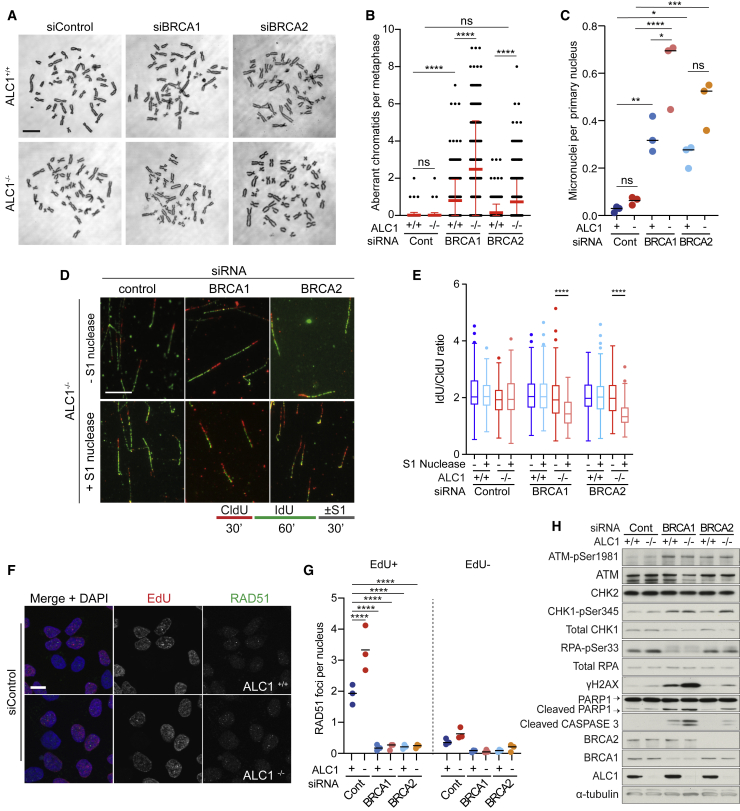
Loss of HR leads to single-stranded gaps at replication forks and gross genomic instability in ALC1−/− cells(A–D) Knockdown of BRCA1/2 in ALC1−/− cells results in genome instability. (A) Representative micrographs of metaphase spreads in ALC1+/+ and ALC1−/− eHAP transfected with the indicated siRNA. (B) Quantification of the number of aberrant chromatids per metaphase in ALC1+/+ and ALC1−/− eHAP transfected with indicated siRNA. Data are mean ± SEM (n = 3 independent biological experiments). (C) Quantification of number of micronuclei per primary nucleus from ALC1+/+ and ALC1−/− eHAP cells transfected with non-targeting, BRCA1-targeting, and BRCA2-targeting siRNAs. Data are means from individual experiments; bar represents median (n = 3 independent biological experiments). (D) Lower: scheme of the nucleotide labeling and S1 nuclease treatment strategy used for gap detection at the replication fork. Upper: Representative DNA fiber immunofluorescence images from ALC1−/− eHAP cells transfected with the indicated siRNAs and treated or not with S1 nuclease.Scale bars represent 100 μm.(E) Boxplot showing mean IdU/CldU ratio in ALC1+/+ and ALC1−/− eHAP transfected with the indicated siRNAs and treated or not with S1 nuclease. Data from 500–600 fibers/condition are represented as mean ± SD (2 technical replicates from 2 independent biological experiments).(F) Representative micrographs of ALC1+/+ and ALC1−/− eHAP cells transfected with non-targeting siRNAs stained with RAD51 antibody, EdU click-iT, and DAPI. Scale bar, 10 μm.(G) Quantification of nuclear RAD51 foci in CSK pre-extracted EdU+ and EdU− ALC1+/+ and ALC1−/− eHAP cells transfected with indicated siRNAs 72 h following knockdown. Data are means from individual experiments; bar represents median (n = 3 biologically independent experiments).(H) Immunoblot of WCEs in ALC1+/+ and ALC1−/− cells transfected with non-targeting, BRCA1-targeting, or BRCA2-targeting siRNAs, probed with ATM pSer1981, ATM, CHK2, CHK1-pSer345, total CHK1, RPA-pSer33, total-RPA, γH2AX, PARP1, cleaved caspase-3, BRCA2, BRCA1, and ALC1. α-tubulin was used as a loading control. ns, p > 0.05; ∗p < 0.05; ∗∗p < 0.01; ∗∗∗p < 0.001; ∗∗∗∗p < 0.0001.